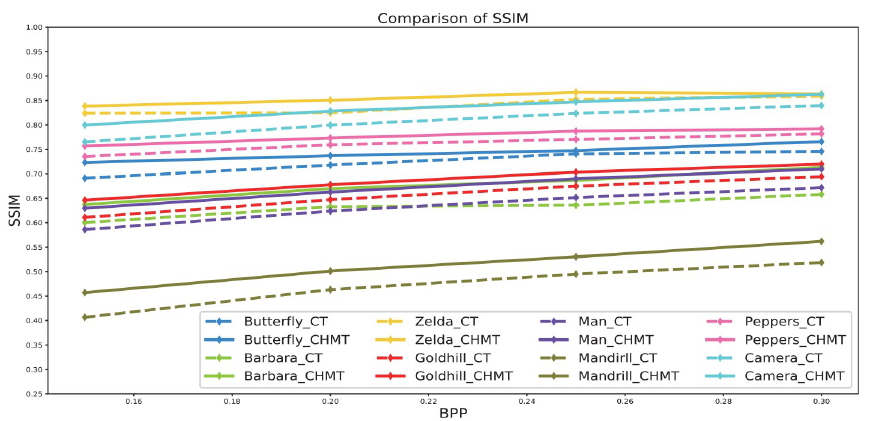
Fig 13. Comparison of SSIM between the contourlet transform and contourlet-HMM–PCNN algorithms.